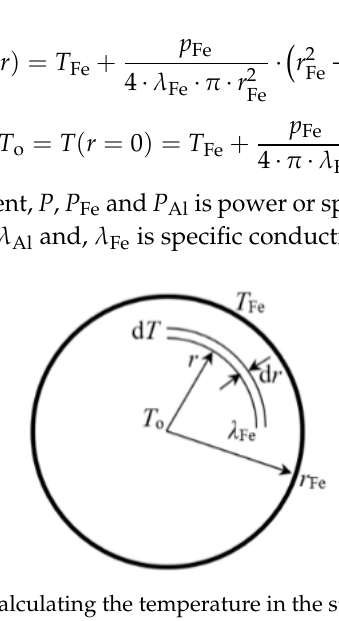
Table 1. Temperature in dependence of